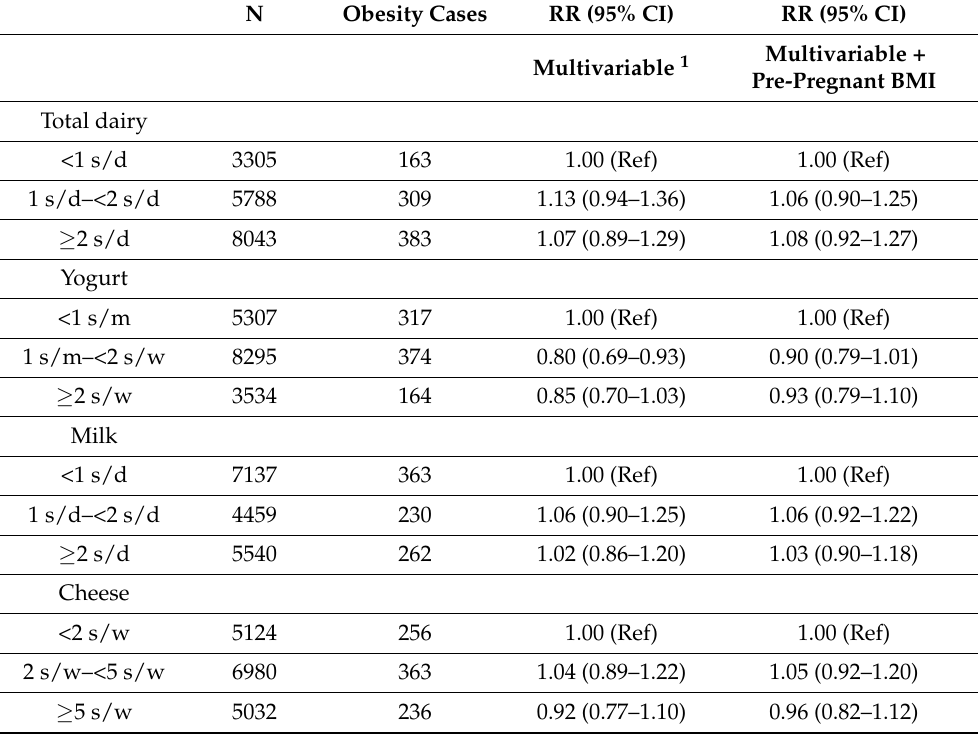
Table 3. Relative Risk of Postpartum Obesity According to Different Dairy Foods Intakes.